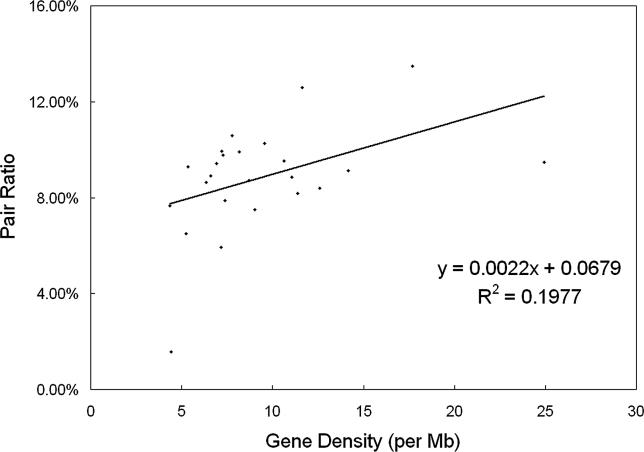
Relationship between Head-to-Head Gene Pair Ratio and Gene Density